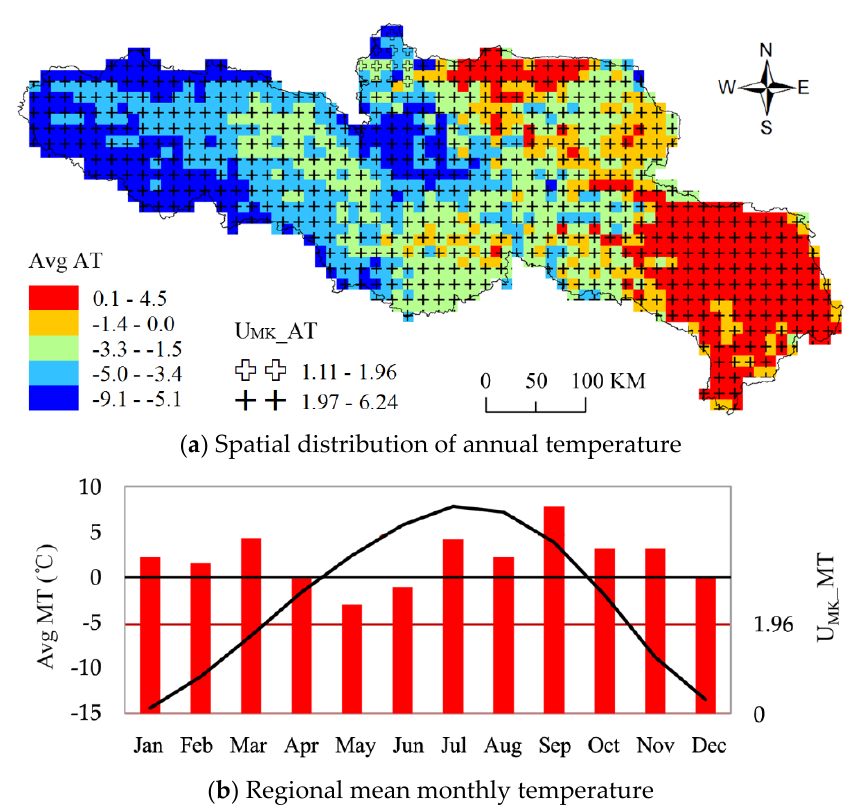
Figure 12. The average annual ( a ) and monthly ( b ) air temperature and the M–K test statistic during 1979–2015 in the SRYR.